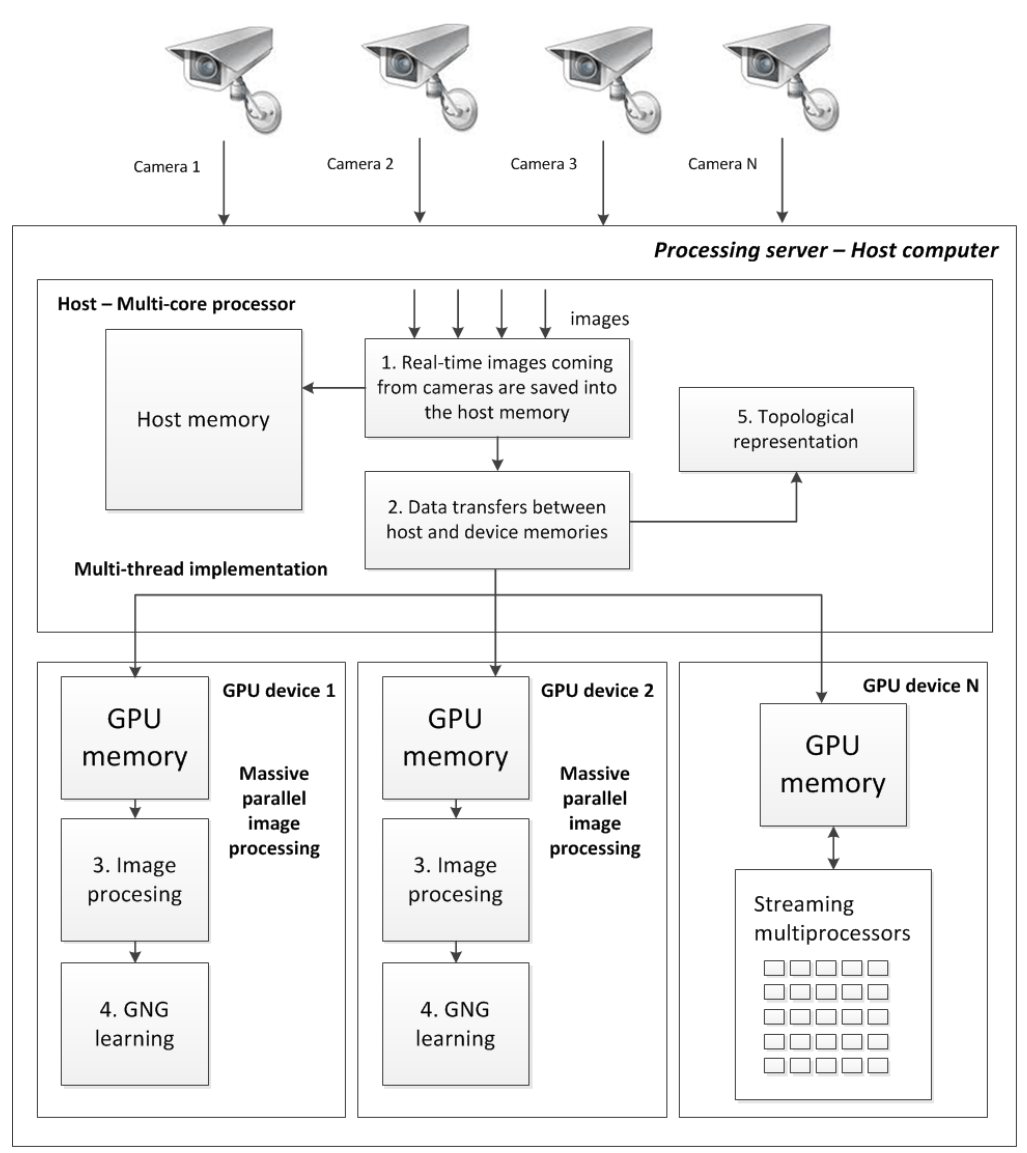
Figure 6. Multi-GPU multi-camera